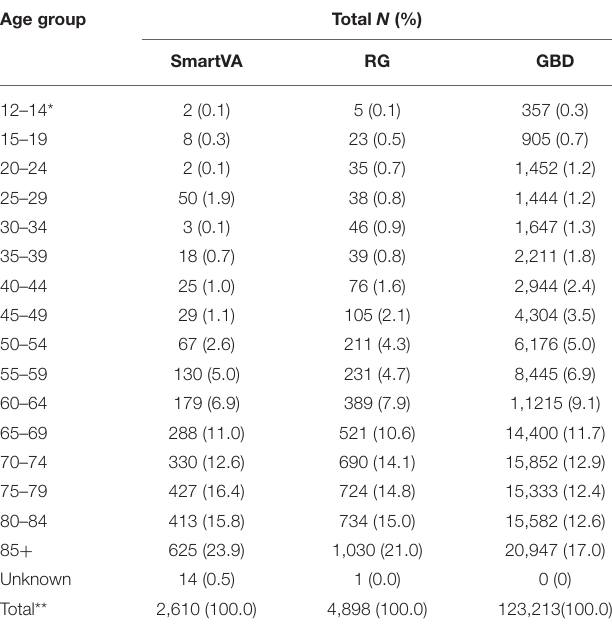
TABLE 2 | Cause specific mortality fractions (after-redistribution of undetermined cases), adult deaths, Sri Lanka, 2017–18. Cause Total